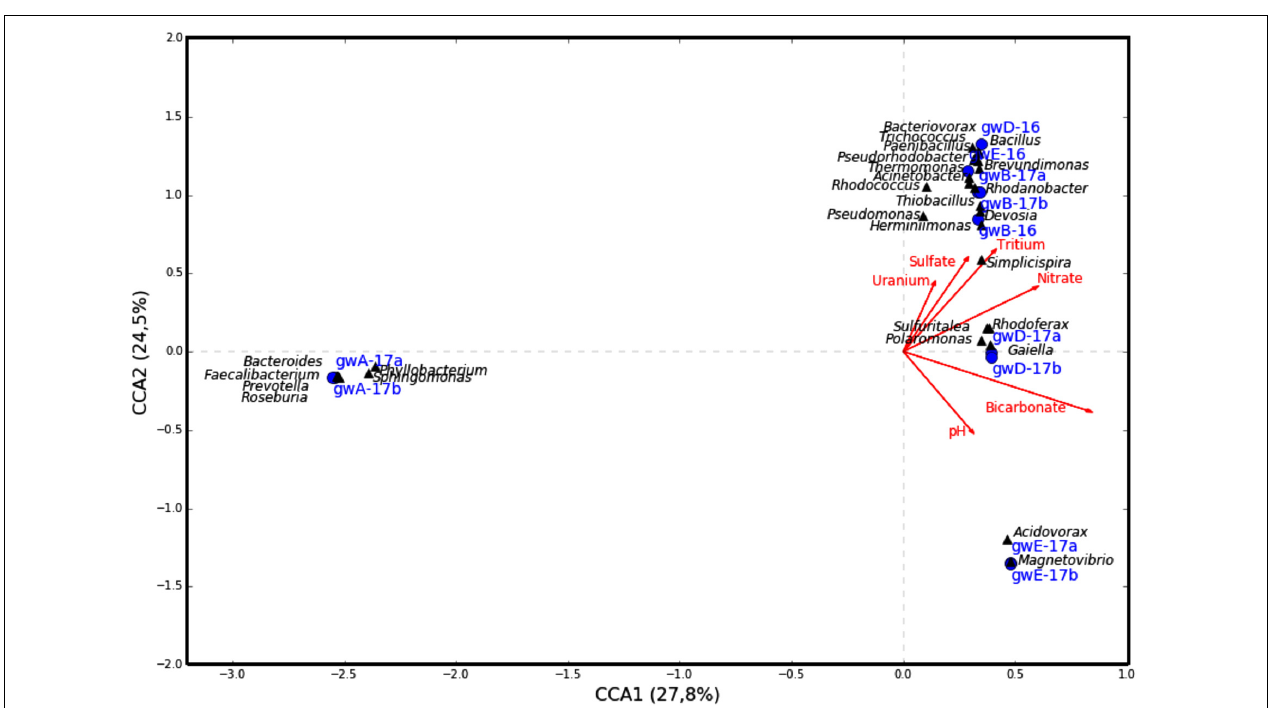
FIGURE 7 | Canonical correspondence analysis showing the correlation between bacterial diversity at the genus level and geochemical parameters of the groundwater